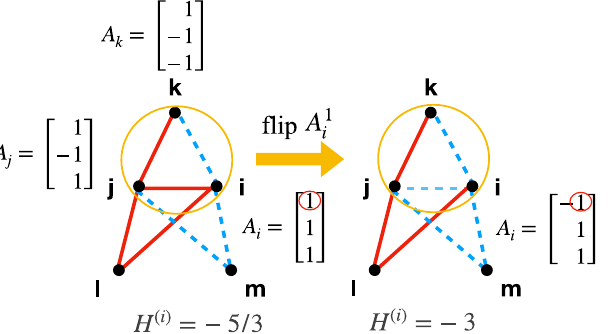
Figure 1. Co-evolutionary interplay of opinions and links. Red (blue) links denote positive (negative) relationships. Among the three triads in the graph, the chosen one, ( i , j , k ) is circled. We consider the case 1 . As agent i flips one of its attributes, A 1 Q = 3 . The opinion vectors of l and m are A 5 / 3 to from − − figure). Links that do not belong to the three depicted triangles are not shown in the figure. Note that the full network is a ring.